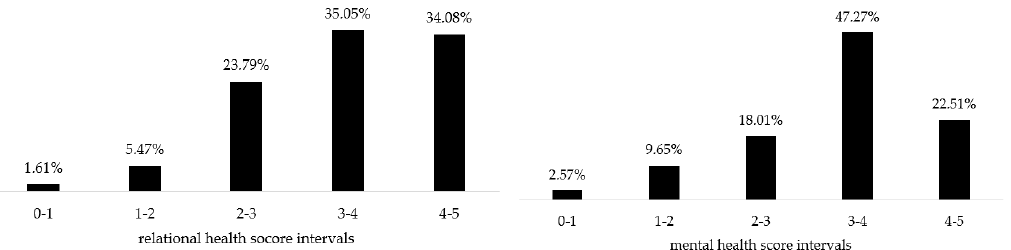
Figure 1. Comparison of respondents’ distribution across intervals of relational and mental health.